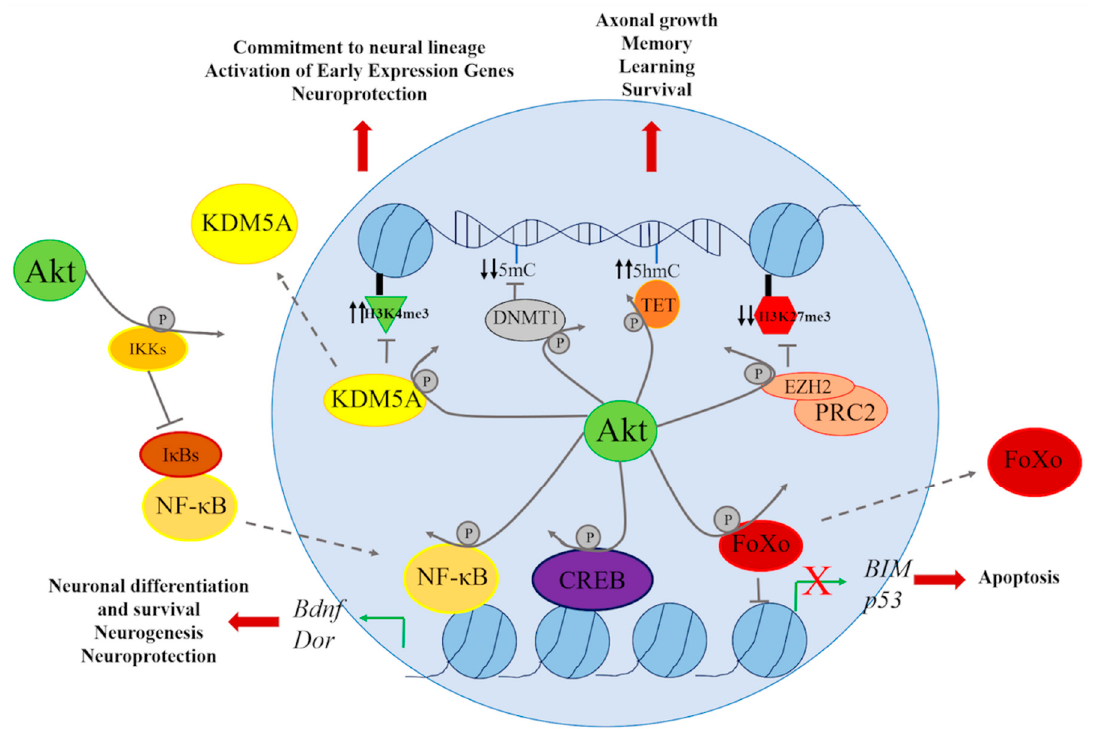
Figure 2. AKT phosphorylates several transcription factors, including NF- κ B, CREB, and FOXO, implicated in the transcription of genes regulating neuronal differentiation, neuroprotection, neurogenesis, and apoptosis, such as Bdnf, Dor, BIM, and p53. PI3K stimulation can also inhibit (KDM5A, DNMT1, and EHZ2) or activate (TET) chromatin-associated proteins leading to upregulation or repression of genes implicated in neural differentiation, axonal growth, memory, and learning through altering chromatin marks in histone tails of DNA modifications.